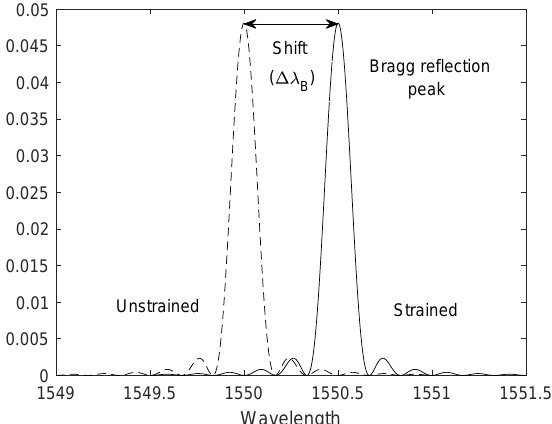
Figure 2. Example spectra of the FBG, indicating the shift in Bragg reflection peak due to the fiber undergoing tension.